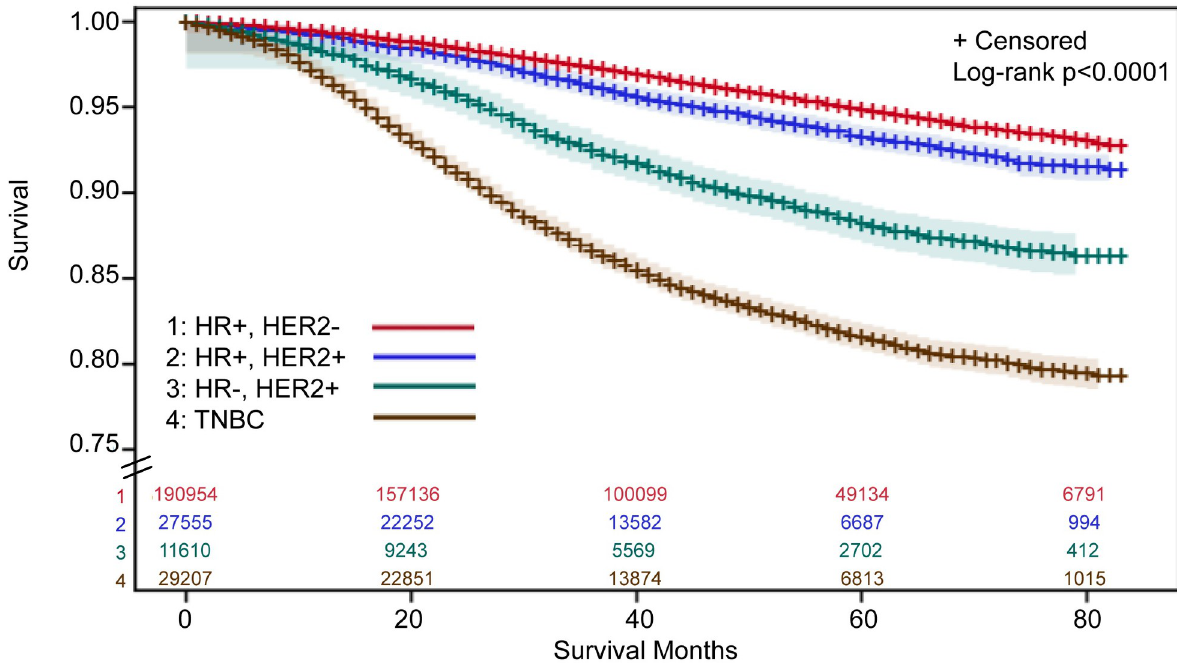
Fig 2. Breast cancer-specific survival estimates 1 for patients with early breast cancer, by HR, HER2 subtype. 1 Survival estimates were derived using Kaplan-Meier methods with 95% Hall-Wellner confidence bands. SEER does not provide cancer-specific survival status for patients with a previous tumor, so those patients were excluded. ⸗ Indicates y-axis was truncated to 0.75–1.00. Abbreviations: HER, human epidermal growth factor receptor; HR, hormone receptor; SEER, Surveillance, Epidemiology, and End Results; TNBC, triple negative breast